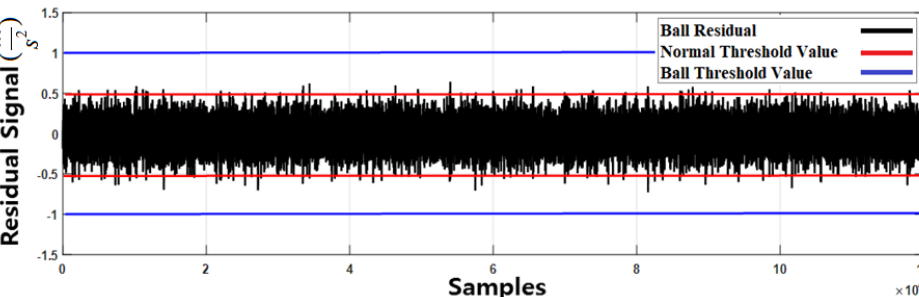
Figure 12. Residual signal and threshold value for the normal condition for a crack width of 6 mm.